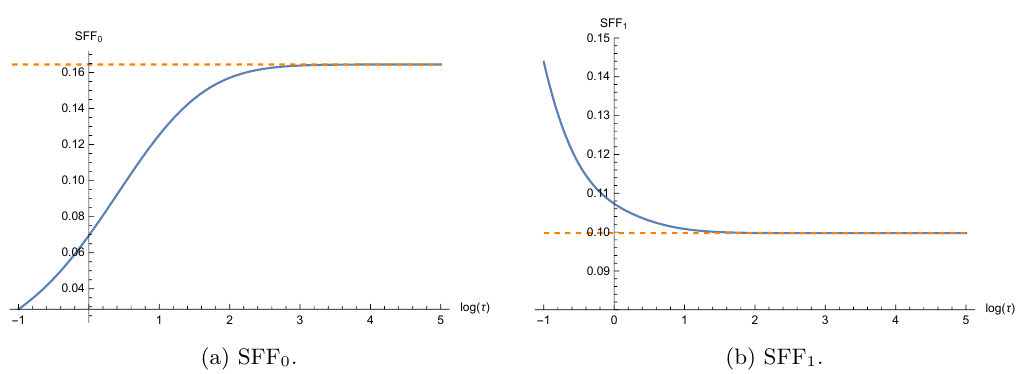
Figure 1 . Plot of (a) SFF 0 and (b) SFF 1 for JT gravity. The horizontal axis is log τ . We set β = 1 in this figure. SFF g approaches h Z (2 β ) i g as τ → ∞ (shown by orange dashed